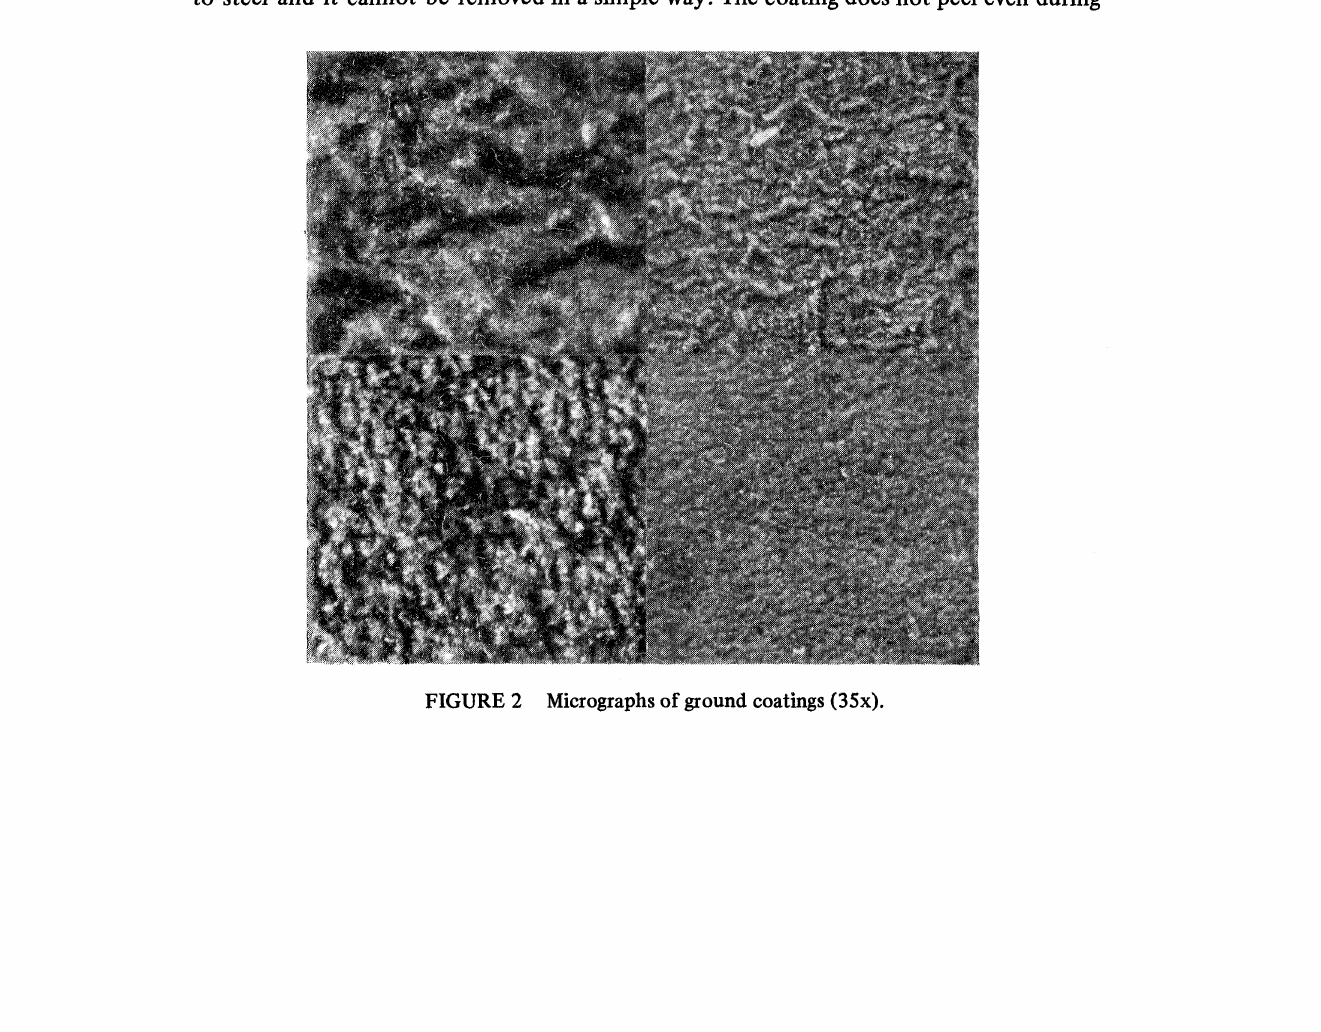
FIGURE 2 Mierographs of ground coatings